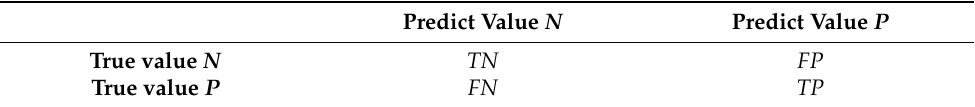
Table 1. Confusion matrix.